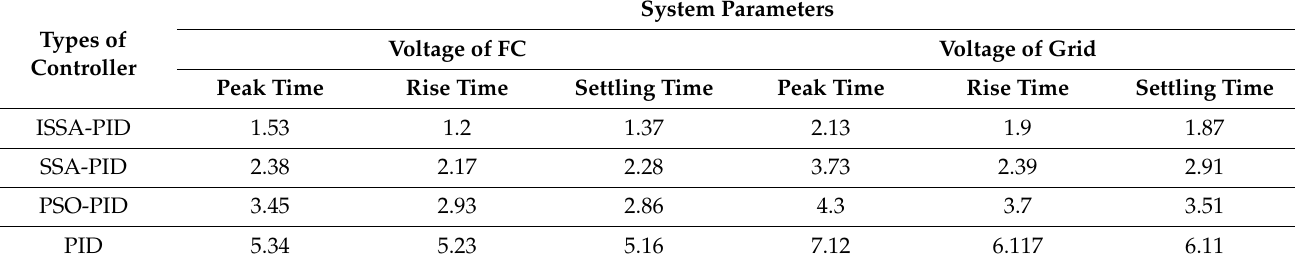
Table 3. Controller Gain Values.